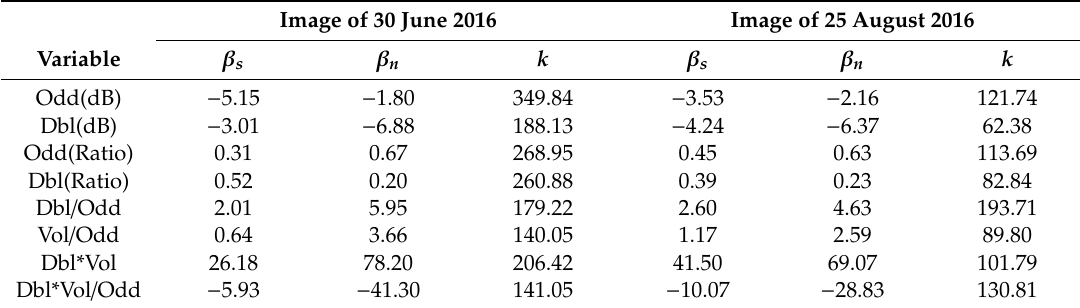
Table 4. Two unknown parameters and saturation level k estimated using di ff erent variables (Odd, Dbl and Vol: Surface scattering, double-bounce and volume scattering,